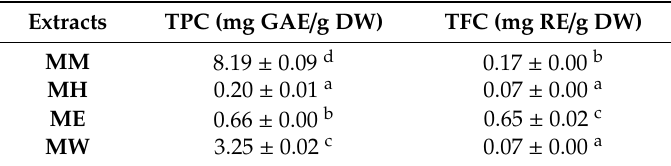
Table 1. Total phenolic and flavonoid contents of extracts from C. indica